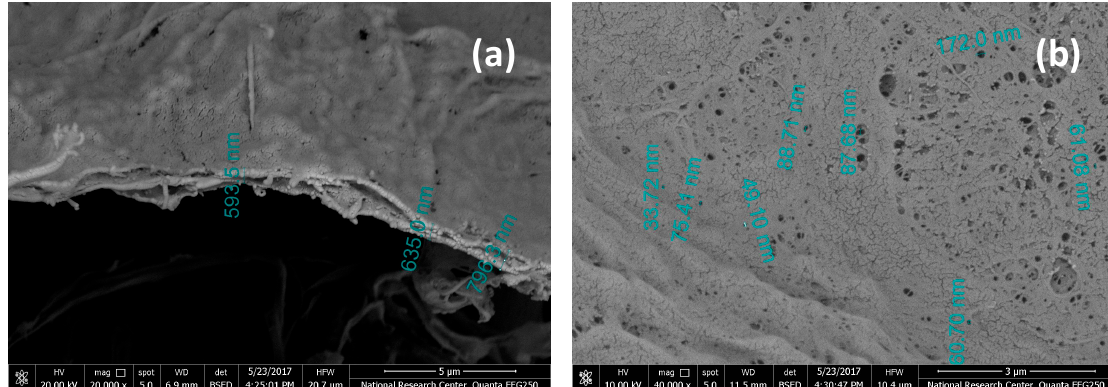
Figure 8. SEM images of: ( a ) cross section and ( b ) surface of alcohol-exchanged CNF films formed on a hardened filter.